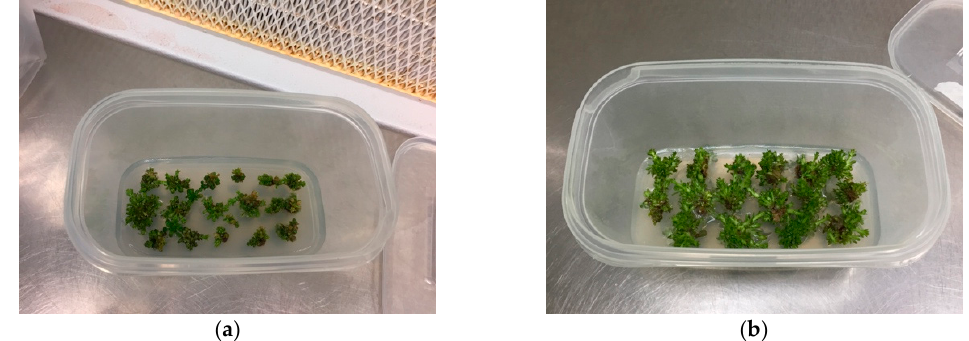
Figure 3. Explants of caper accessions “Sal 37” ( a ) and “Sal 39” ( b ) in solid substrate after 60 days .